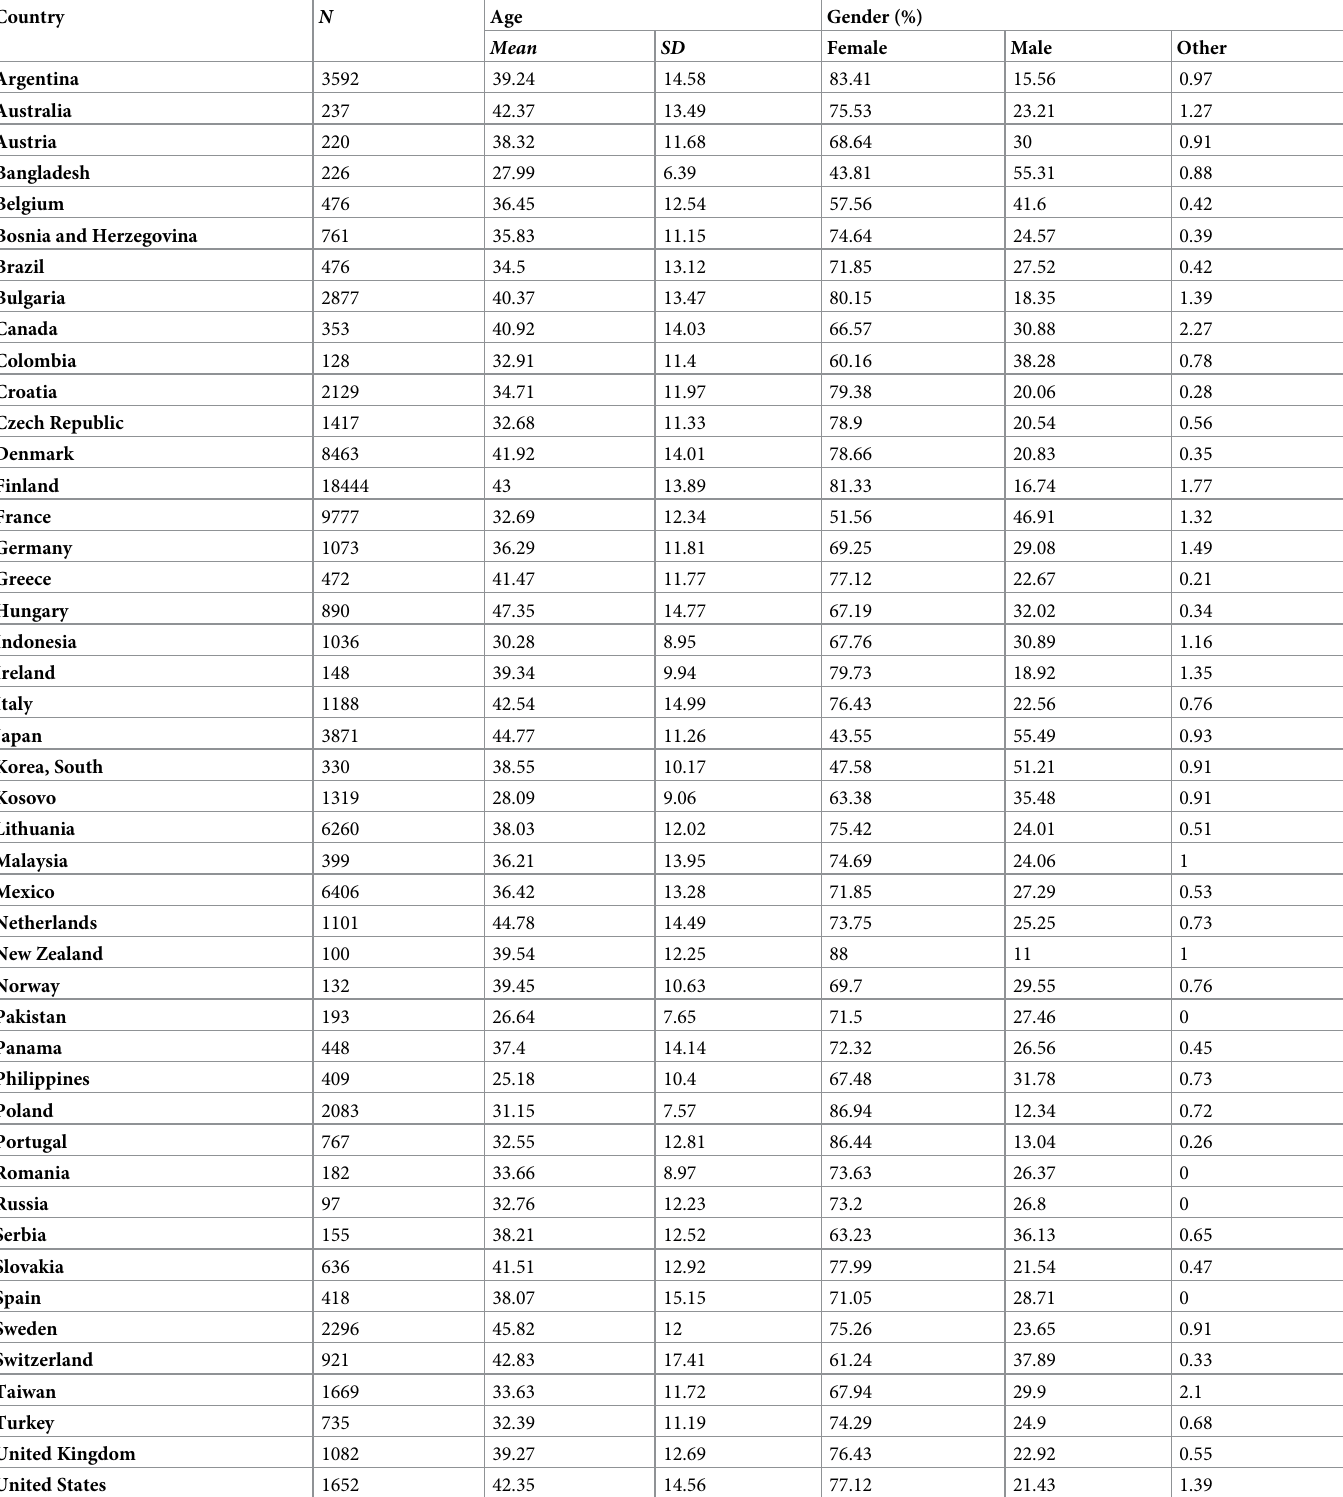
Table 1. Participants: Sample size, age (mean and standard deviation), and distribution by gender across countries included in the analyses.